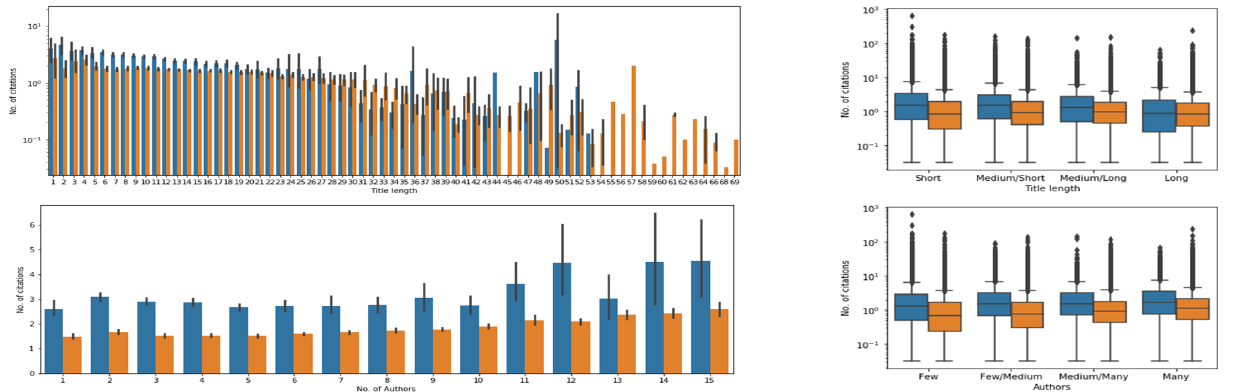
Figure 3. Boxplots representing the number of (normalized) citations in review and original articles (above, left-hand side), subscription-based and open access publications (above, middle), publications with negative or positive title sentiment score (above, right-hand side) and citation count based on the number of colons in the title (below, left-hand side), semicolons (below, middle) or question marks (below, right-hand side). For all the plots, review papers are indicated in blue and original articles in orange.